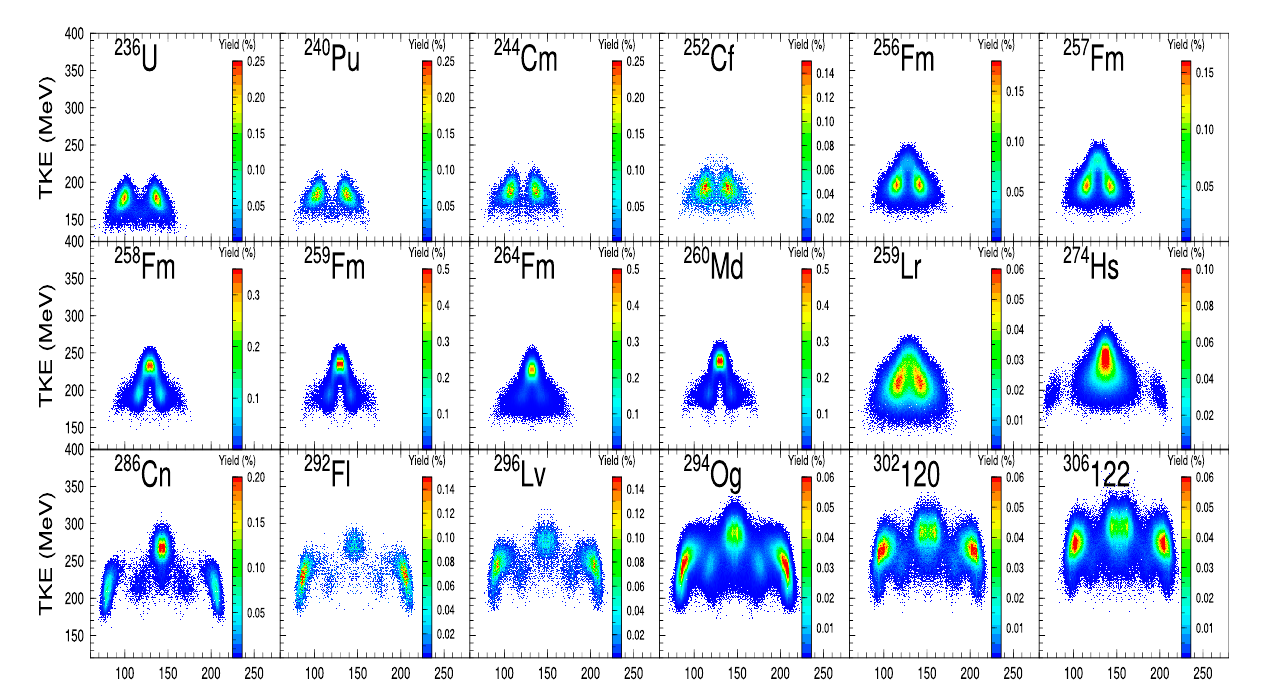
FIGURE 4 Fission fragment ’ s TKE distributions of 236 U to 306 122 at low excitation energy just above their fi ssion barrier height using the four-dimensional Langevin model.